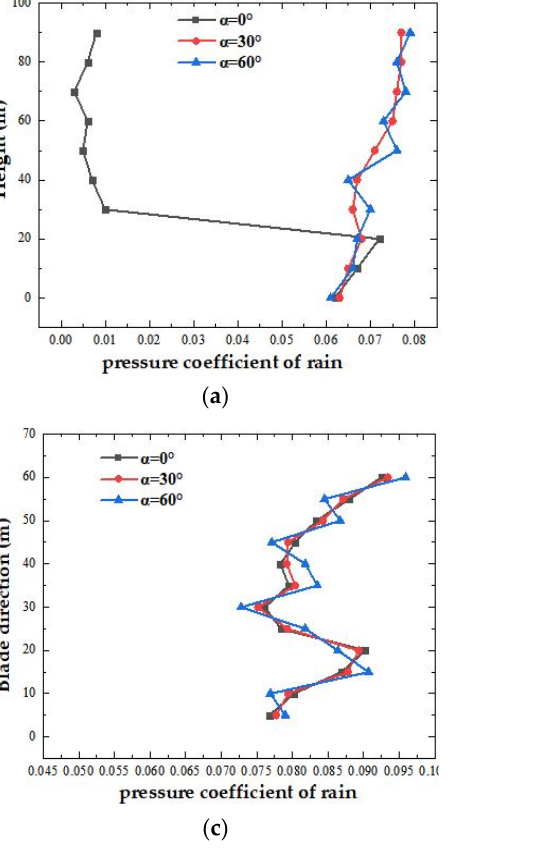
Figure 15. Distribution of rain-induced-pressure coefficient; ( a ) tower; ( b ) blade A; ( c ) blade B; ( d ) blade C.